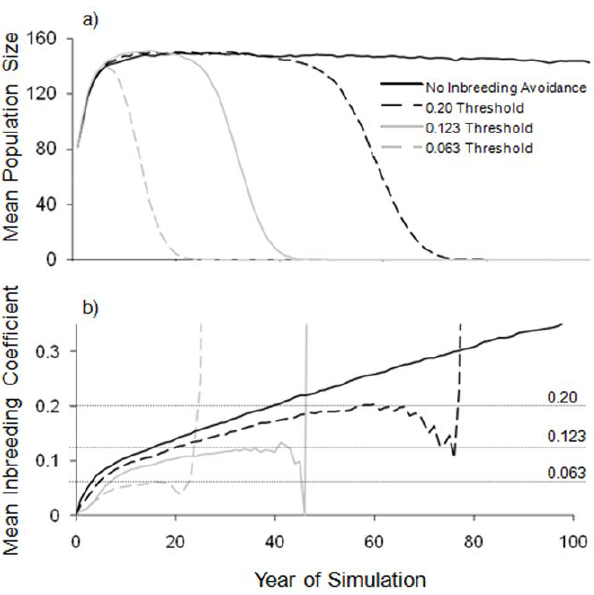
Figure 2. Projections with and without avoidance. Mean projected population size (a) and mean inbreeding coefficients (b) of simulated African wild dog populations over 100 years without inbreeding avoidance behaviours, with prevention of parent-offspring and full-sibling matings (F=0.20), with prevention of half-sibling matings and higher (F=0.123), and with prevention of aunt-nephew/ uncle-niece matings and higher (F=0.063). Dotted horizontal lines in (b) indicate inbreeding thresholds. The erratic behavior of mean inbreeding coefficients just before extinction is the result of very small population sizes that lead to unusual mean values near F=1.0.